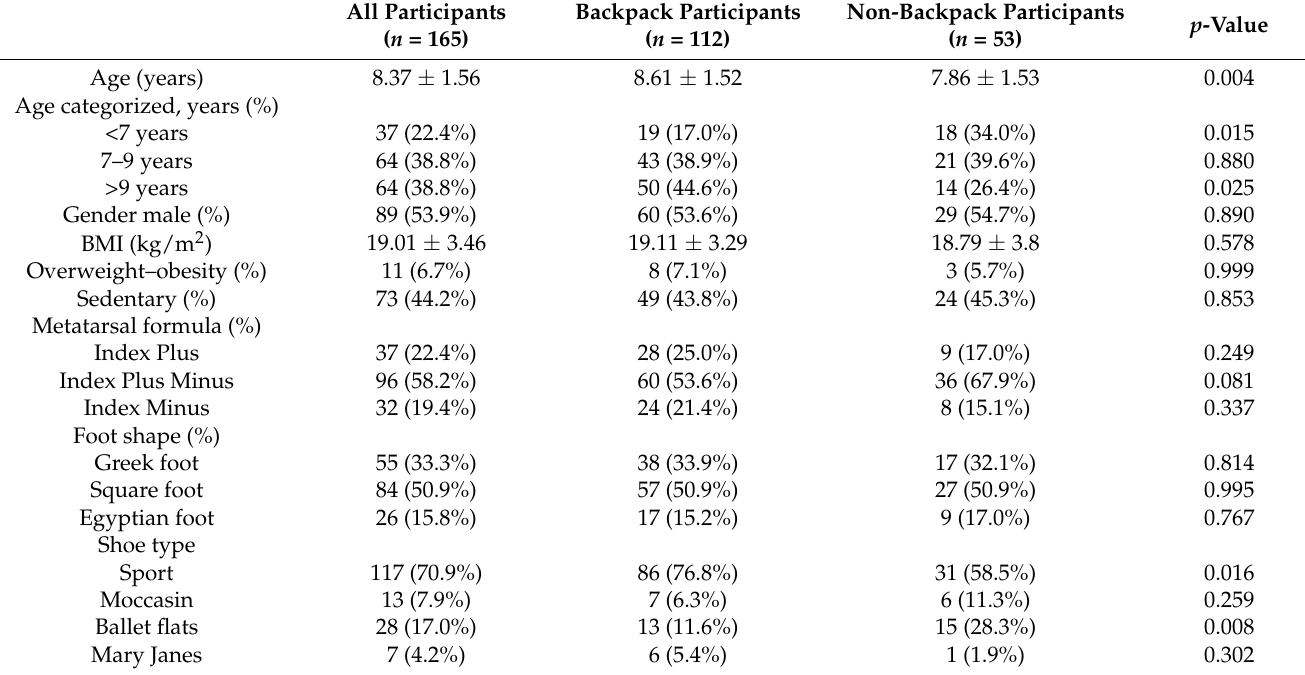
Table 1. Characteristics of the schoolchildren stratified by backpack